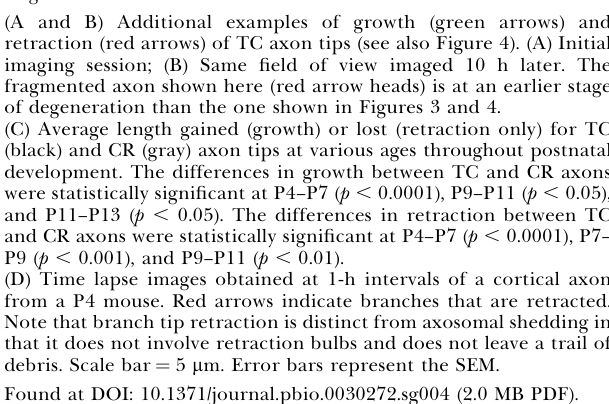
Figure S1. GFP Expression Pattern in L21 Transgenic Mice Immunocytochemistry was performed to detect GFP on coronal sections from line L21 brains at P7. (A) Primary somatosensory cortex. Note that cortical pyramidal neurons do not express GFP at this early stage. Branching of TC axons in layer 4 delineates barrels (asterisks). Scale bar ¼ 100 l m. (B) High magnification of inset in (A) showing axons in layer 1 (arrows). Scale bar ¼ 10 l m. (C) Coronal view of a CR cell (arrowhead) and CR axon (arrow) in layer 1. Scale bar ¼ 60 l m. (D) Thalamus (Th). Insets 1 and 2 are shown at higher magnification in E and F, respectively. Scale bar ¼ 220 l m. (E and F) Higher-magnification views of the thalamic neurons shown